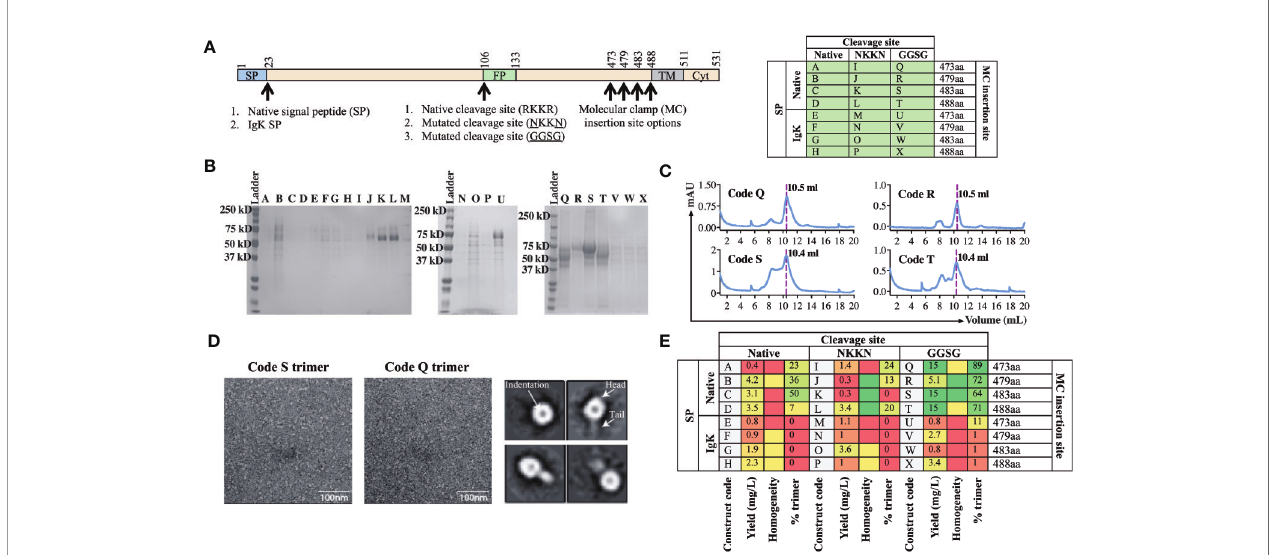
FIGURE 3 | Production and analysis of AchPV2-Fclamp antigens. (A) The cloning strategy delineating the 24 different constructs that were desginated to be cloned for the generation of the AchPV2-Fclamp. The table shows the alphabetized (A – X) construct codes based on the different permutations of introducing signal peptides, cleavage sites, and the Molecular Clamp following removal of the transmembrane and cytosolic regions of the F. The mutations introduced to the putative native cleavage site are underlined. (B) SDS-PAGE analysis of the expressed AchPV2 Fclamp proteins under reducing conditions. (C) Representative size exclusion chromatographs for construct codes Q, R, S, and T which were the four highest expressing constructs. The dotted line overlaps with the trimer peak and the elution volume of this peak is indicated. (D) Representative 30,000× images of the TEM negative stain analysis of the trimeric fraction from the size excluded AchPV2- Fclamp codes S (left) and Q (middle). Representative 2D averages for Q, characteristic indentation was visible in the head domains, some particles appear with head and tail features. (E) Summary of the puri fi cation and in vitro analysis of the AchPV2 Fclamp constructs highlighting the expression yield, percentage of the puri fi ed protein in the trimeric conformation and the homogeneity of the proteins on an SDS-PAGE. For the homogeneity analysis: red shaded = least homogenous or no proteins corresponding to AchPV2-Fclamp, yellow shaded = intermediate homogeneity, and green shaded = highly